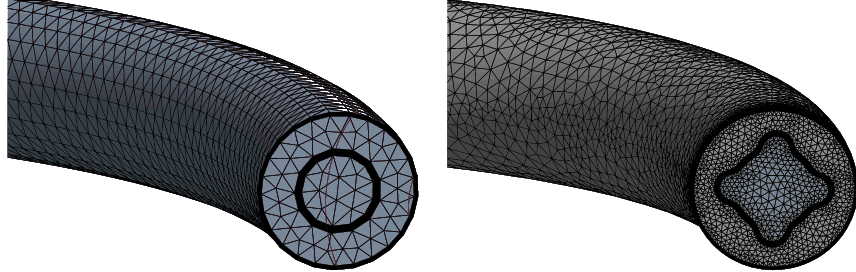
Figure 2. Mesh for geometry A (tube-in-tube) and B (four ridges without